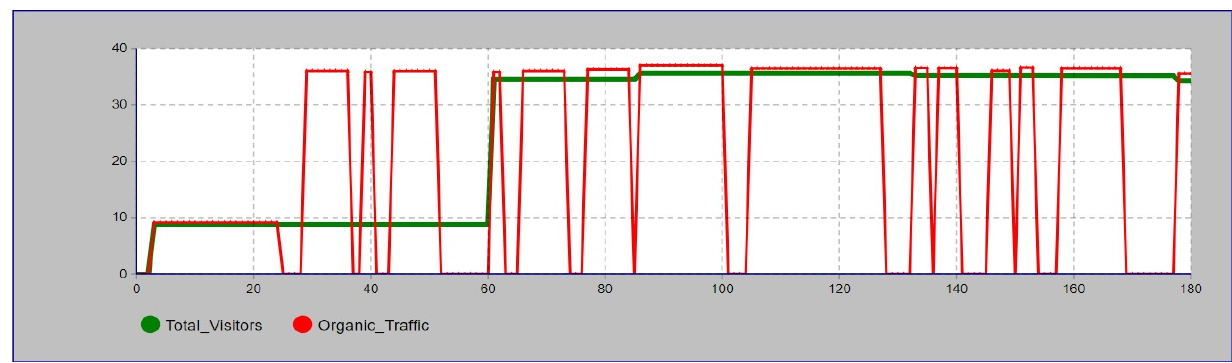
Figure 7. The time chart depicts the history of the contribution of the following traffic factors: Social traffic and Paid Traffic during 180 days. Figure 8. The time chart depicts the history of the contribution of the following visibility factors: Organic traffic and Total visitors during 180 days.